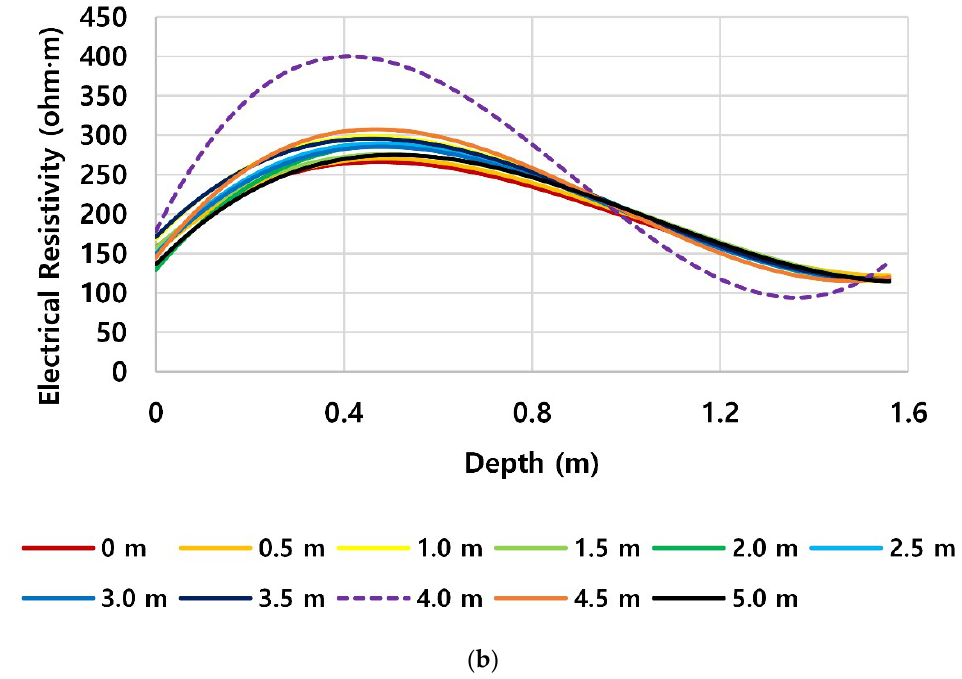
Figure 14. Trend lines of the ER according to the depth at each position. ( a ) Absence of anomaly zone (Section No. 1). ( b ) Existence of anomaly zone (Section No. 3).